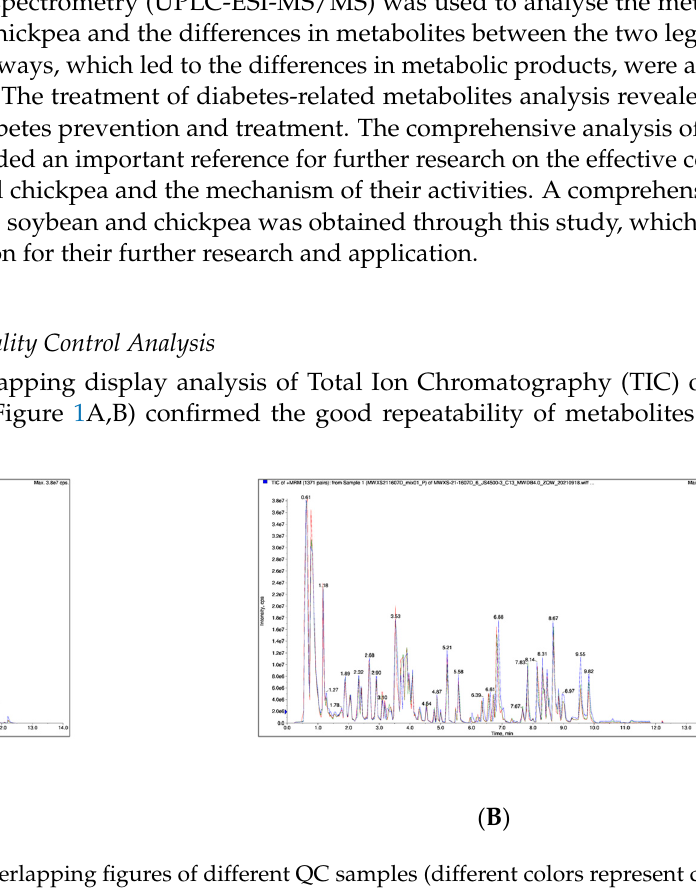
Figure 2. The CV distribution of each group. 2.2. Widely Targeted Metabolomics Analysis in Chickpea and Soybean The primary and secondary metabolites of the two legumes were analysed by widely targeted LC-MS/MS to study the chemical constituents of chickpea and soybean (Figures S1 and S2). The relative contents of metabolites were analysed by the MRM mode using MultiQuant software (Figure 3A,B). A total of 776 metabolites, including more than 10 classes, were detected (Table S1 and Figure 4A,B). Some of these classes could be further divided into several secondary classifications (Table 1). ( A ) ( B ) Figure 3. Multi-peak figure for MRM metabolite detection (each different colored mass spectrum peak represents one metabolite detected). ( A ) Negative ion mode. ( B ) Positive ion mode.